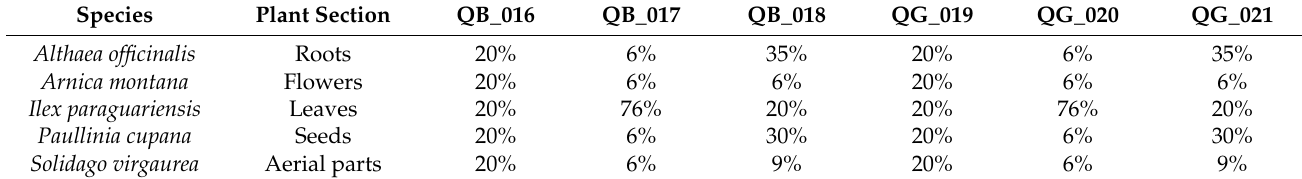
Table 3. The percentages of the plants used for the mock mixture creation. Samples QB_016, QB_017 and QB_018 were created starting from the biomasses of raw plants, and samples QG_019, QG_020 and QG_021 were created starting from the genomic DNA.